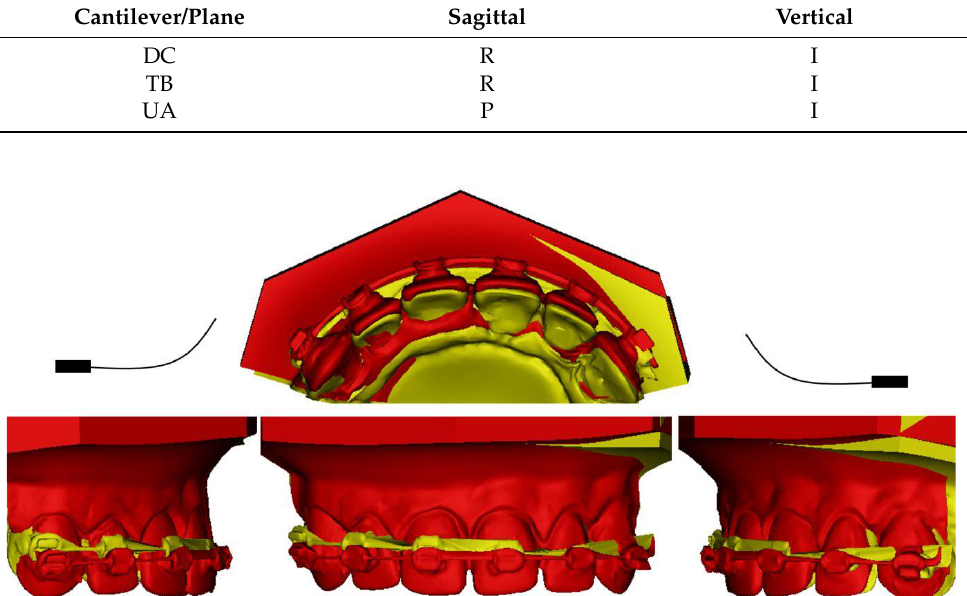
Figure 2. Cantilever design: ( A ). tip-back (TB) ( B ). utility arch (UA) ( C ). deep curve (DC).